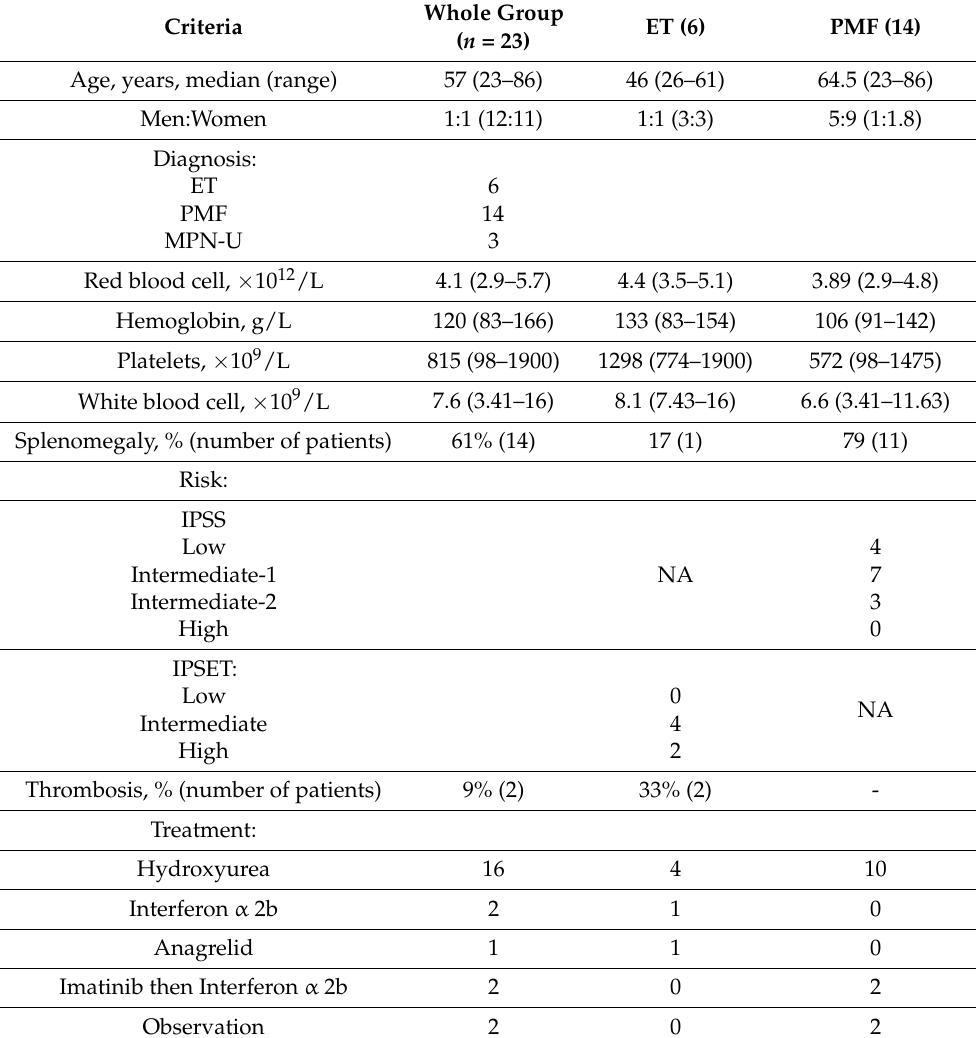
Table 3. Clinical and laboratory characteristics of MPN patients with combined